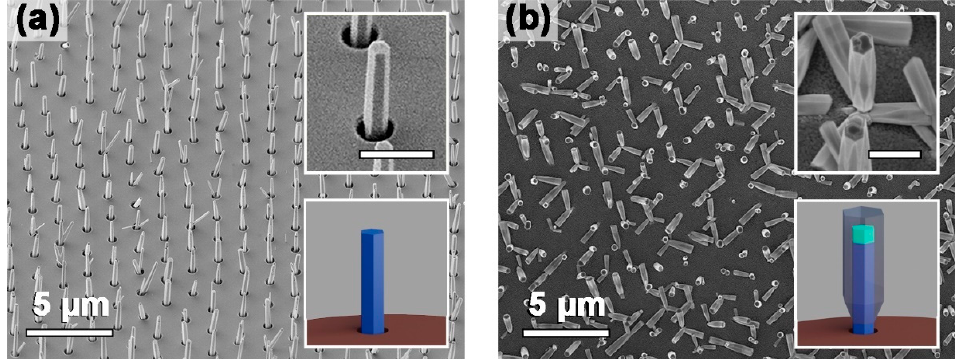
Figure 2. SEM images of the arrays of ( a ) n-GaN and ( b ) n-GaN/i-InGaN/p-GaN NWs grown on n-Si substrates. The inserts show the schematic view of the synthesized nanostructures (not in scale) and the enlarged SEM images (the scale bar is 1 µm).